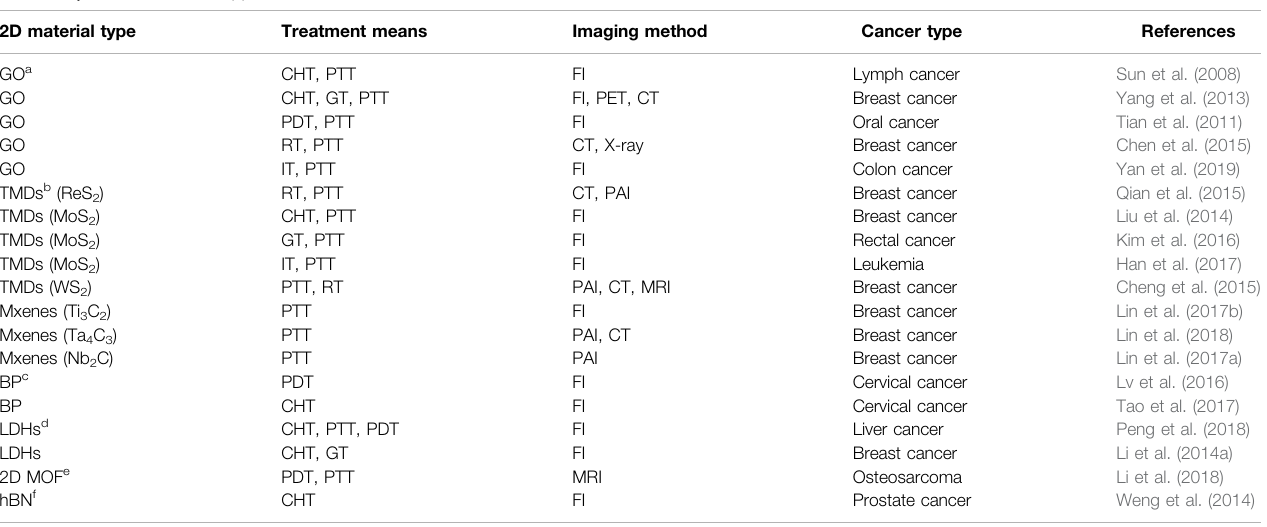
TABLE 1 | Classi fi cation and applications of 2D material used for multimodel theranostics of